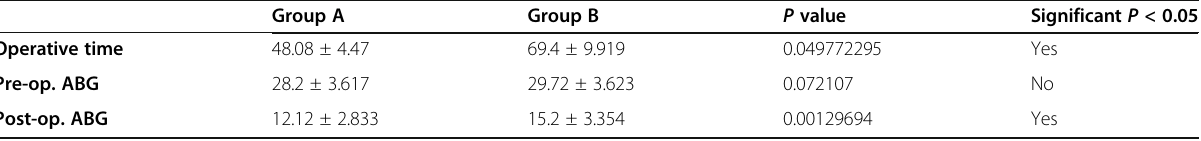
Table 1 Statistical comparison between both groups as regards the operative time and the pre and post-operative ABG